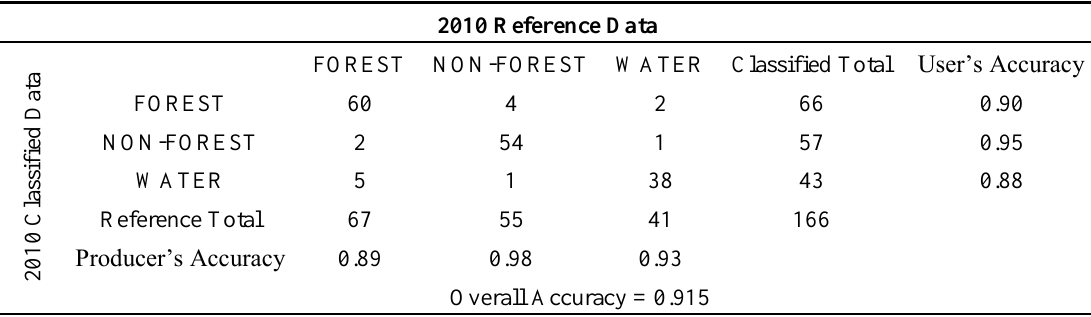
Table 5. Error matrix for the 2010 classified forest/non-forest data accuracy assessment.